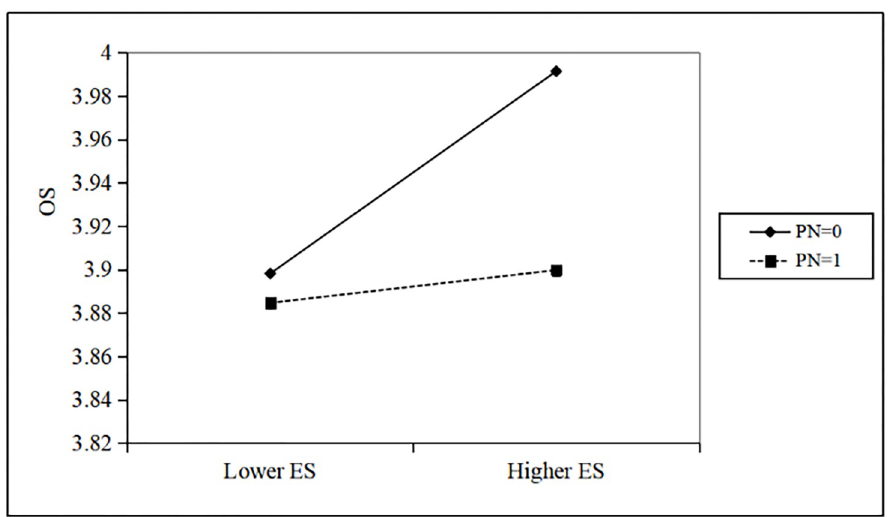
Fig 3. The moderating effect of property rights